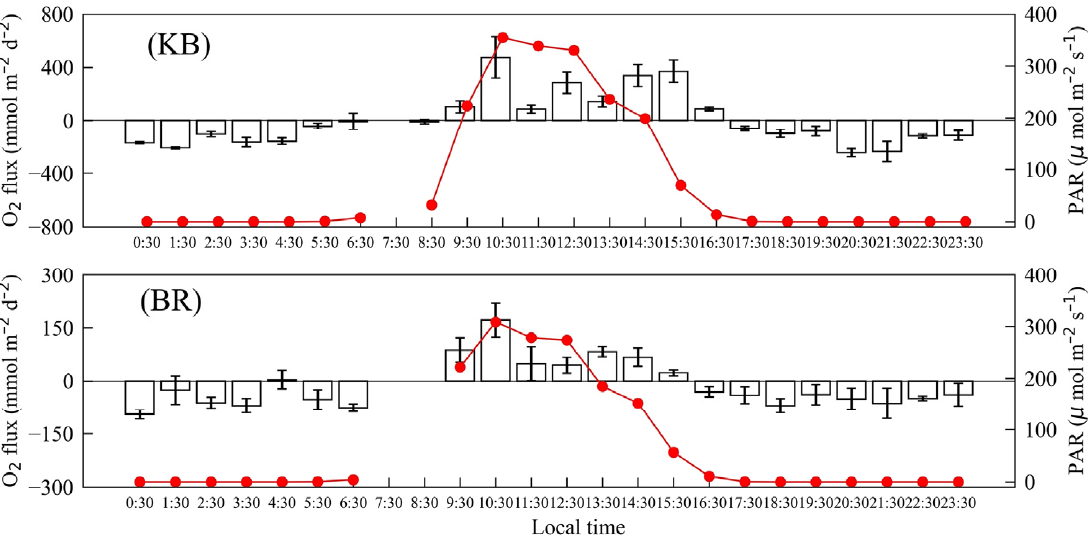
Figure 6. Hourly average O 2 flux (open bar) for 24 h and PAR (red line) in KB and BR. The bars represent standard errors.